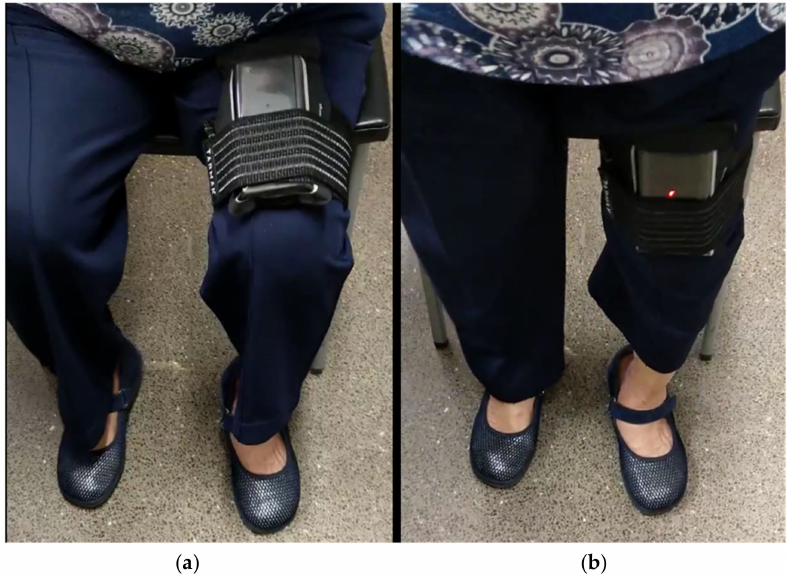
Figure 2. Position and alignment of the sensing device on a subject’s thigh. ( a ) The wearable sensor is placed on the subject’s thigh longitudinally aligned with her femur. The sensor is tightly attached to the subject’s thigh with a Velcro strap to prevent it from sliding. The LED in the sensor is turned o ff when the subject is sitting; ( b ) and it is turned on every time a valid SiSt transition is